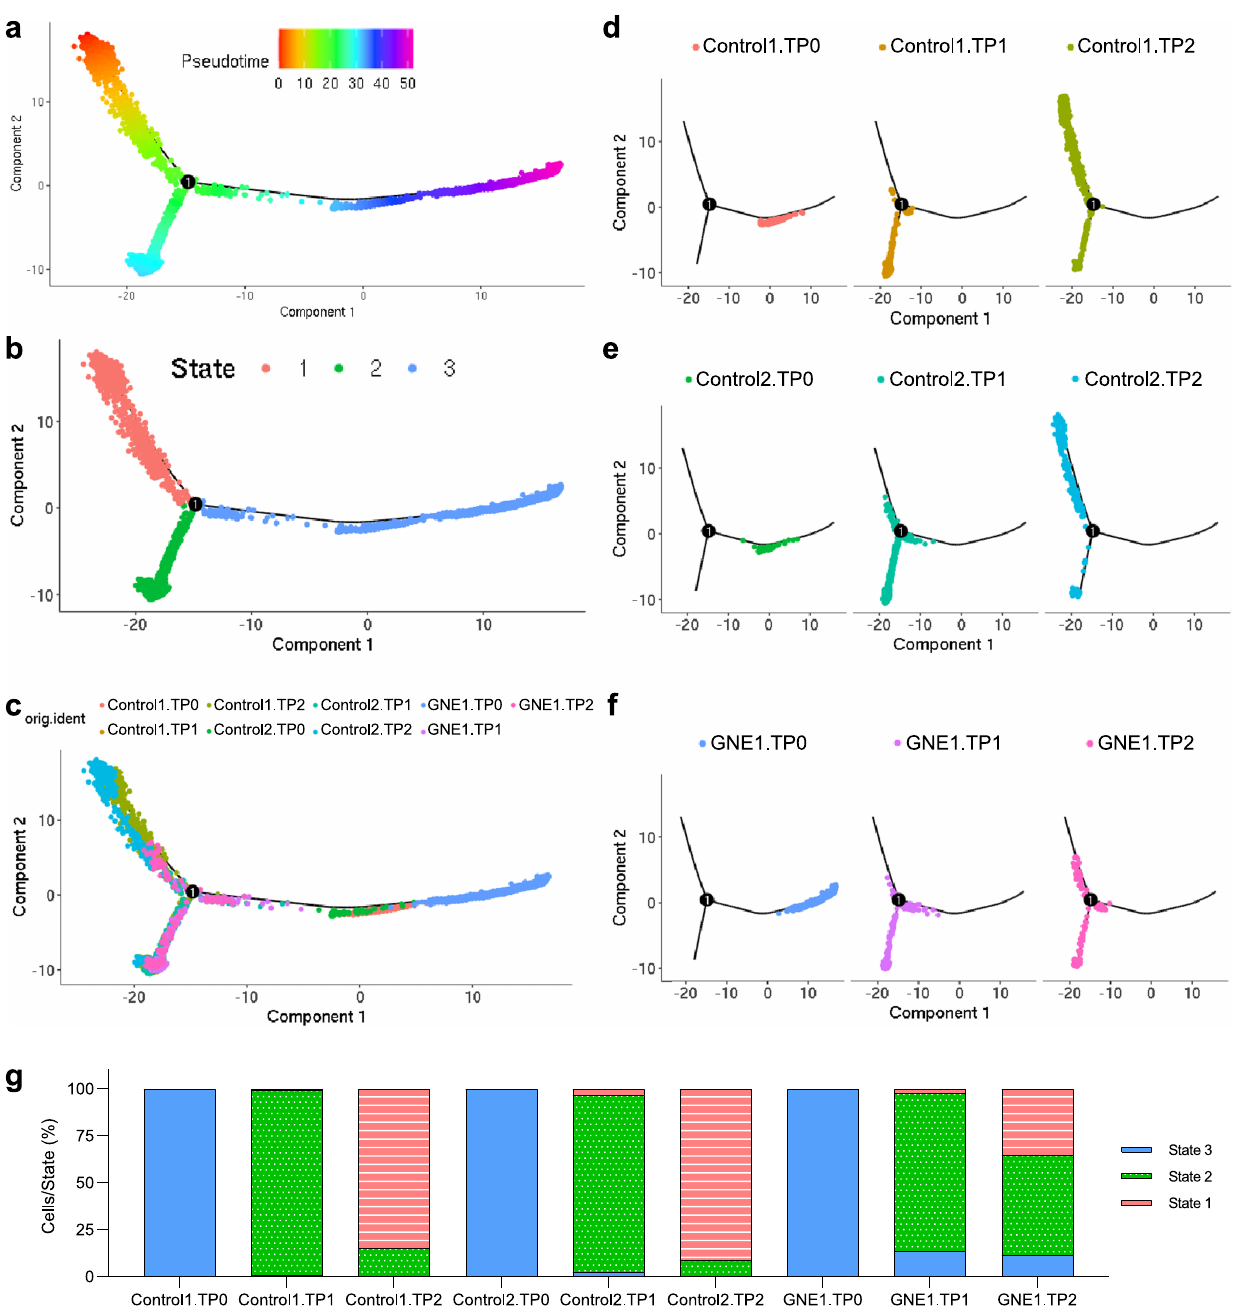
Fig. 6 Pseudotime analysis reiterates inhibited myogenic progression of GNEM patient-derived cells compared to healthy controls. a – f Pseudotime trajectory analysis across all time points using single cells from Control 1 (Control1), Control 2 (Control2), and GNE 1 (GNE1). a Single-cell projected trajectory painted by pseudotime across all differentiation states, b the 3 projected state branches were based on differentially expressed genes (DEGs), c all single-cell samples mapped onto branches, and d Control1, e Control2, and f GNE1 individual single-cell samples mapped onto branches. g Proportion of cells from each sample that fall within state 1 (red and lined), state 2 (green and dotted), and/or state 3 (blue